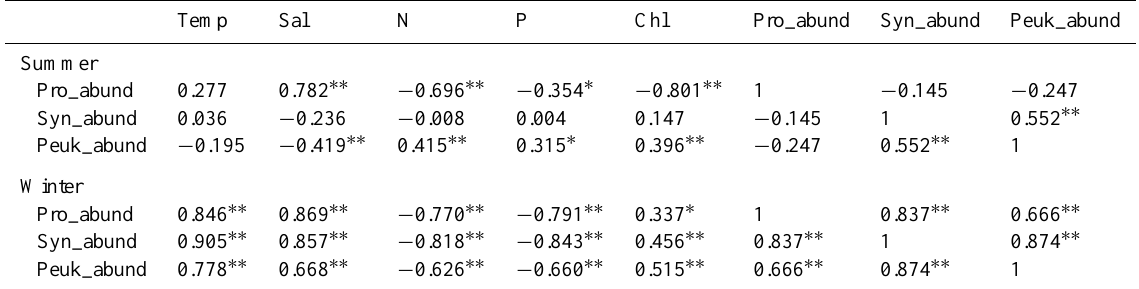
Table 2. Spearman’s rank correlation coefficient between environmental factors and abundances of picophytoplankton